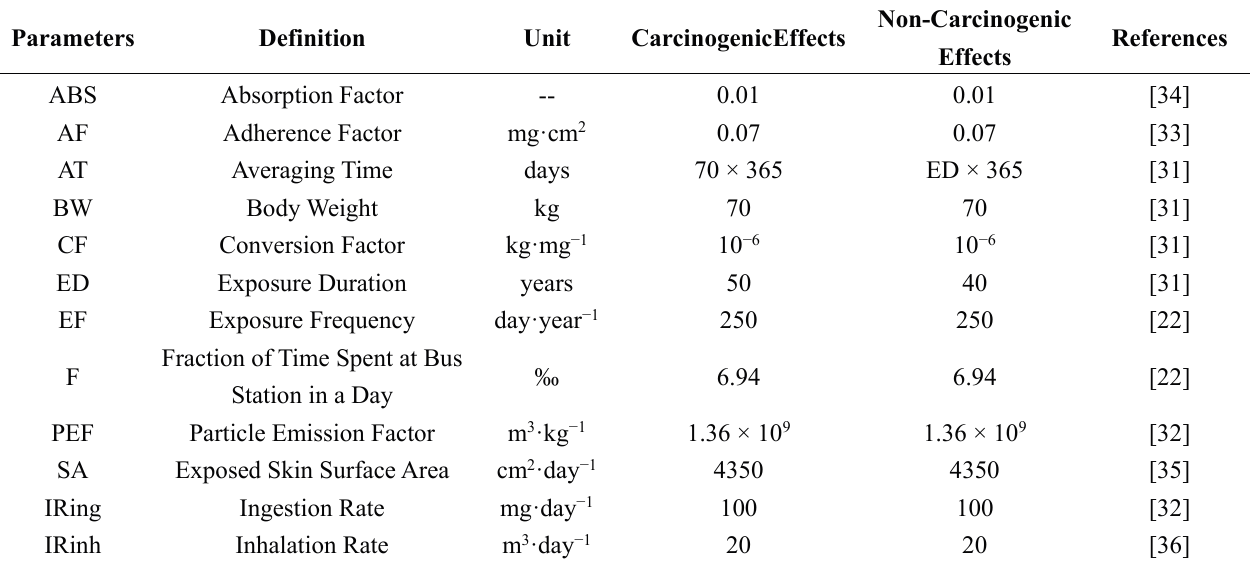
Table 1. Parameters applied in exposure assessment